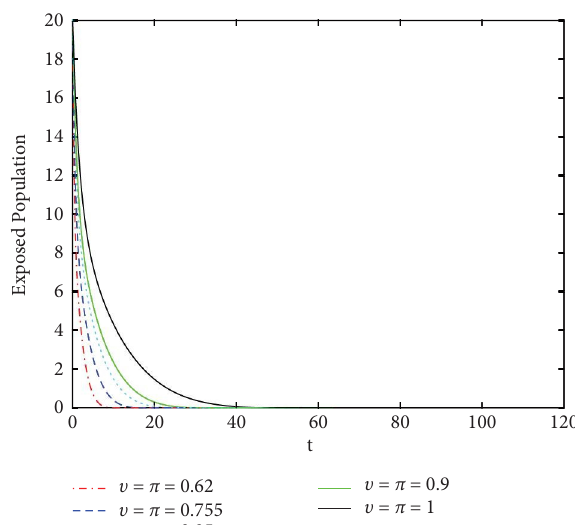
Figure 21: Te dynamics of exposed human population for various fractal-fractional orders.